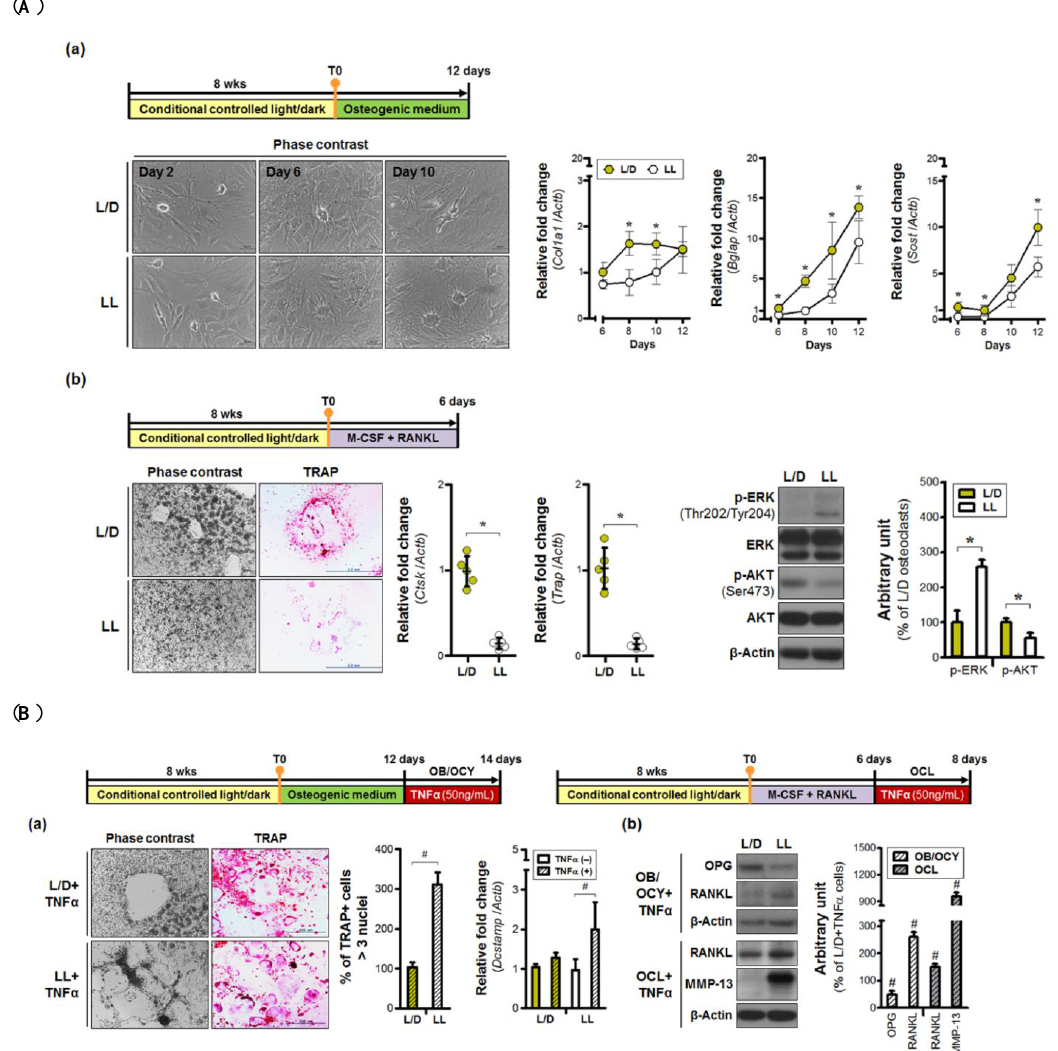
Figure 2. Detrimental e ff ects of continuous lighting on bone cell biology. ( A ) Continuous lighting inhibits di ff erentiation of precursor cells in mature ( a ) osteoblasts and ( b ) osteoclasts. ( a ) The relative fold changes were calculated relative to values from 6 days of calvarial osteoblasts isolated from the light / dark (L / D) group. ( b ) Levels of gene expression were compared relative to that of the L / D group. ( B ) Continuous light exposure increases not only cell fusion-mediated formation of multinuclear osteoclasts, but also the level of catabolic factors in bone cells in response to an inflammatory stimulus. The relative gene expression was measured by comparing values from each lighting condition to those from the TNF α -free group. T0, primary cell isolation; OB, osteoblast; OCL, osteoclast; OCY, osteocyte. OB magnification × 40; OC magnification × 40. * p < 0.05 L / D vs. LL; # p < 0.05 L / D + TNF α vs. LL + TNF α.